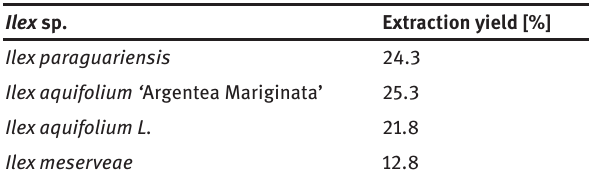
Table 3: The per cent extraction yield of Ilex species.